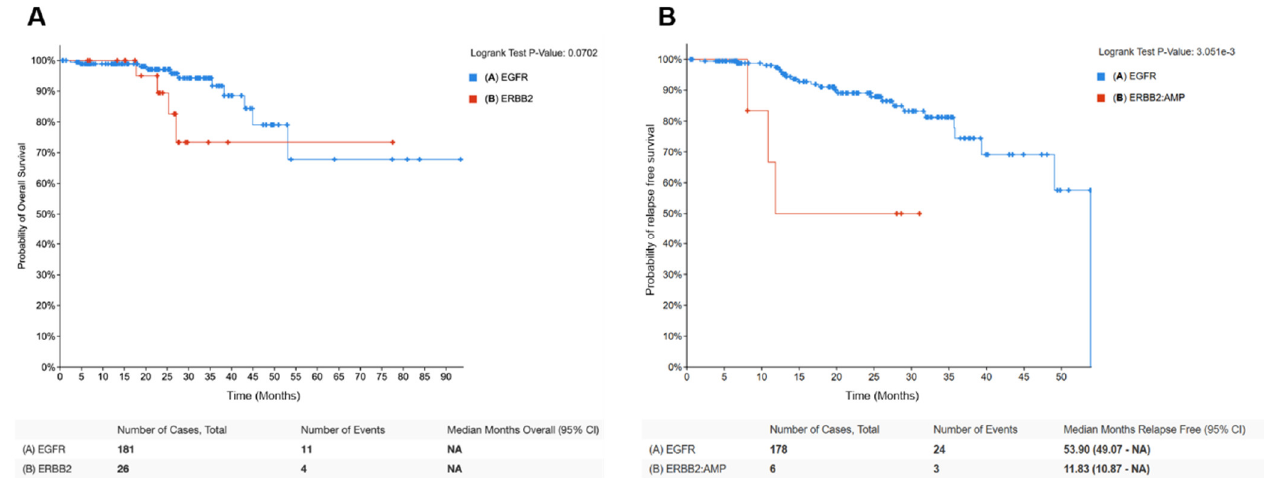
Figure 1. Kaplan–Meier curves and univariate survival analysis (log-rank test) of patients from the MSKCC 2020 lung adenocarcinoma cohort (604 patients). ( A ). Overall survival of patients with EGFR -mutant vs. HER2 -mutant lung adenocarcinomas ( B ). Relapse-free survival of patients with EGFR -mutant vs. HER2 -amplified lung adenocarcinomas.